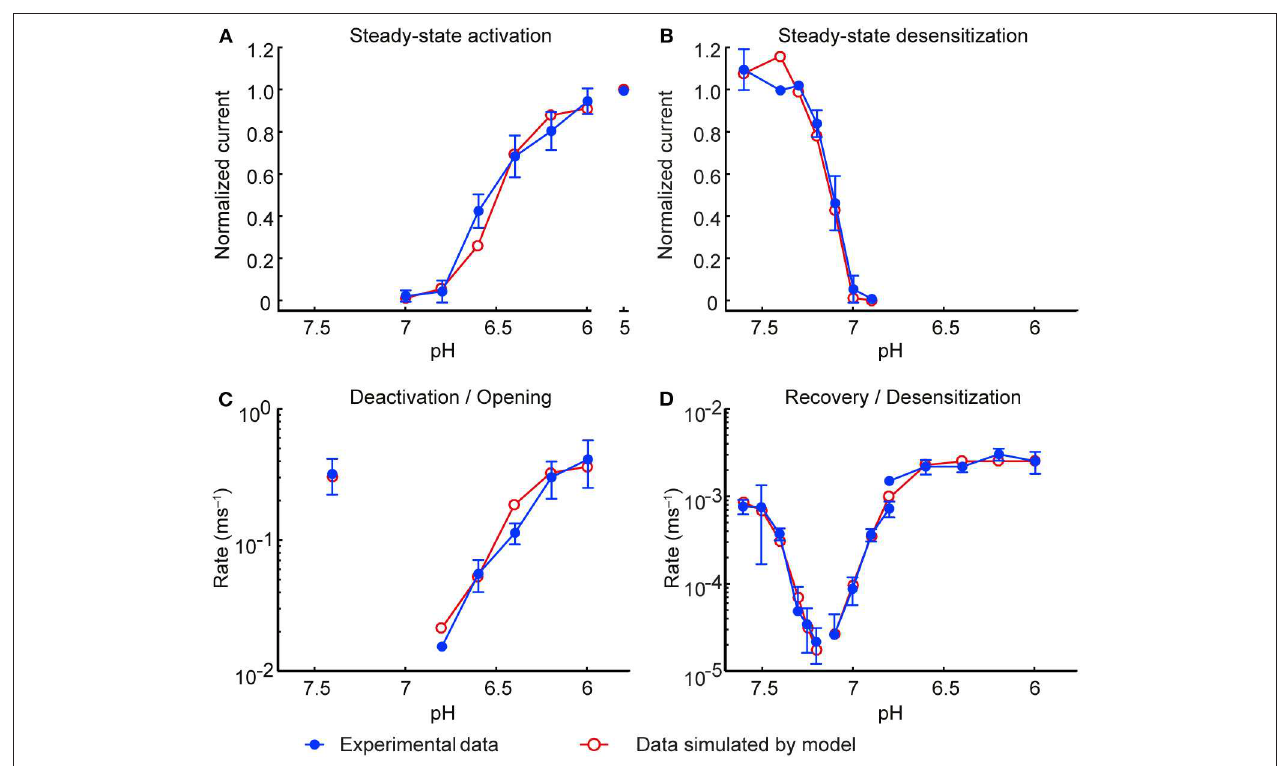
FIGURE 3 | Model of the ASIC1a current: simulations vs. experiments. Experimental data are shown in blue and model results in red. Currents were measured from CHO cells stably expressing ASIC1a, in the whole-cell mode ( A,B ; D except for desensitization from the open state) or from excised outside-out patches ( C ; D , desensitization from the open state). (A) Steady-state activation. (B) Steady-state desensitization (SSD). Experimental data in A and B are the same as in Figures 2A,C ; the corresponding protocols are described in the legend of Figure 2 . (C) Rate of opening and deactivation. (D) Rate of desensitization and recovery from desensitization. Experimental data in (C,D) are the same as in Figure 1F . In all simulations, the model was subjected to the same pH protocols and its output to the same analyses in the